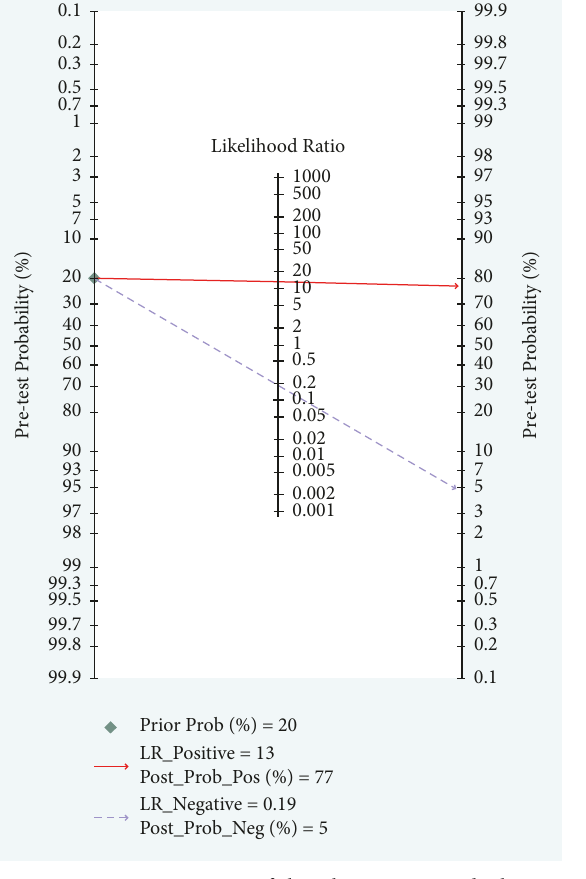
Figure 8: Fagan nomograms of the Cho/Cr ratio and Cho/NAA ratio of the radiation injury group and the recurrent glioma